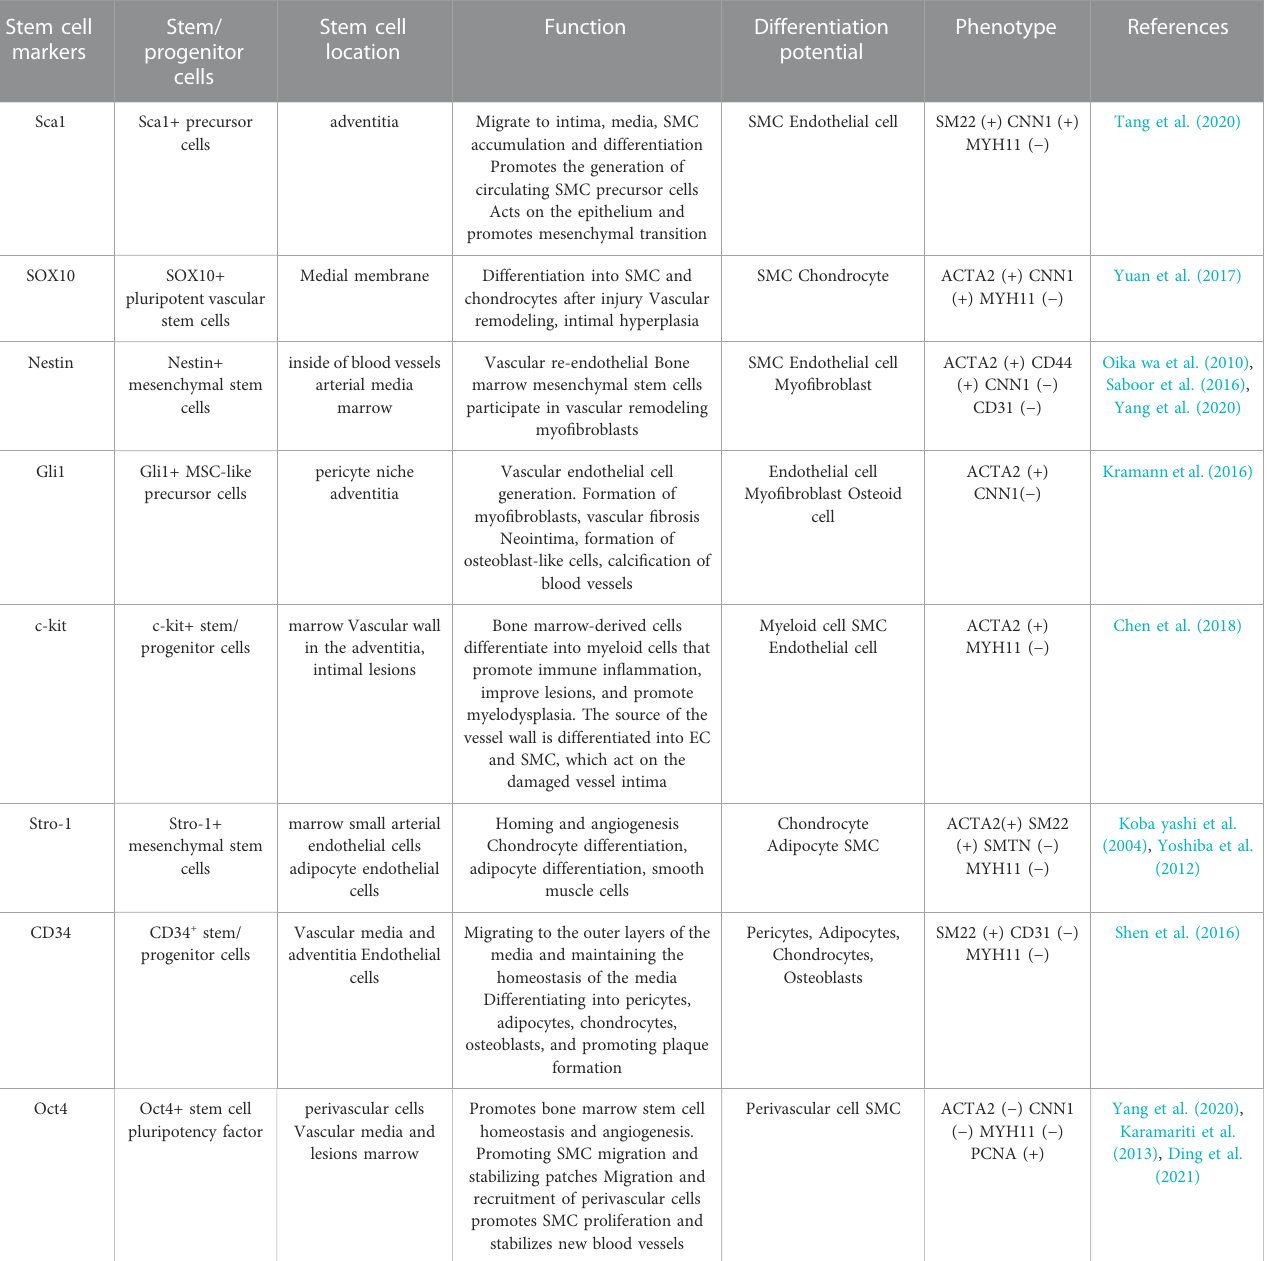
TABLE 1 Stem/Progenitor cells differentiation function and